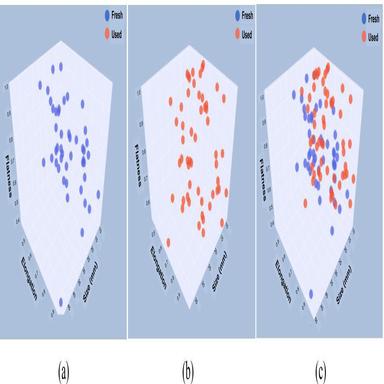
Visualization of the ballast morphology data plot: (a) fresh ballast, (b) used ballast, and (c) fresh and used ballast.